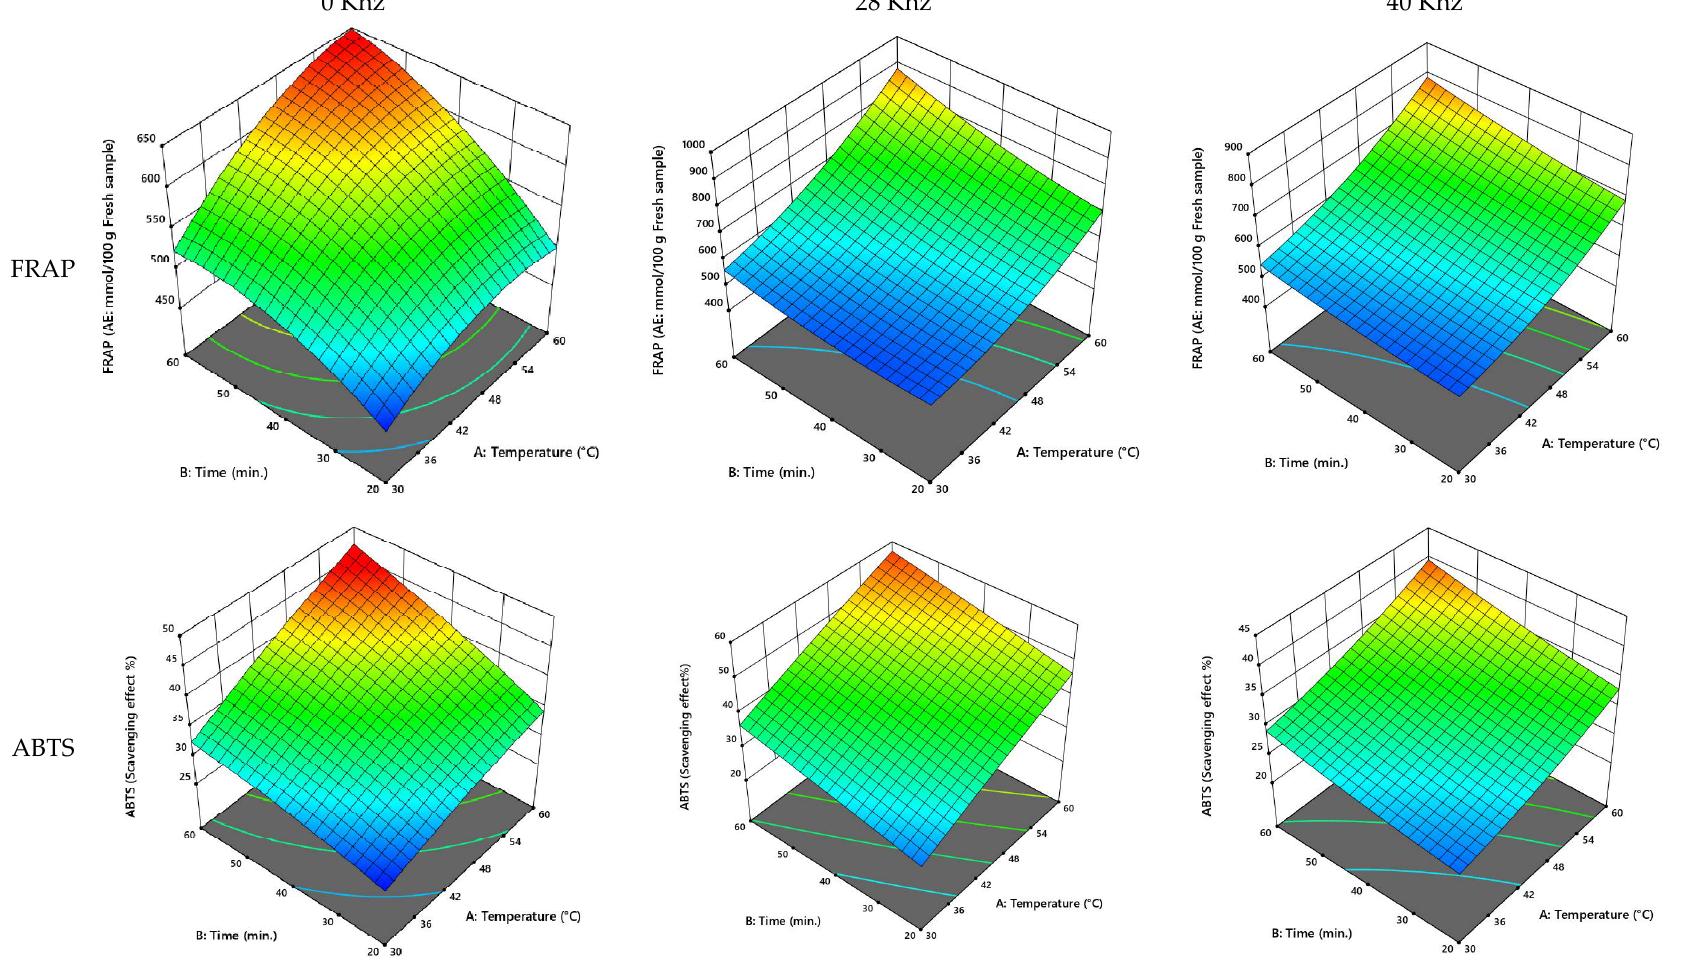
Figure 3. 3D response surface plot for response variables (TPC, TFC, FRAP, and ABTS) as a function of UAE with frequency 0, 28, and 40 kHz in Khalase date palm fruit cultivar.